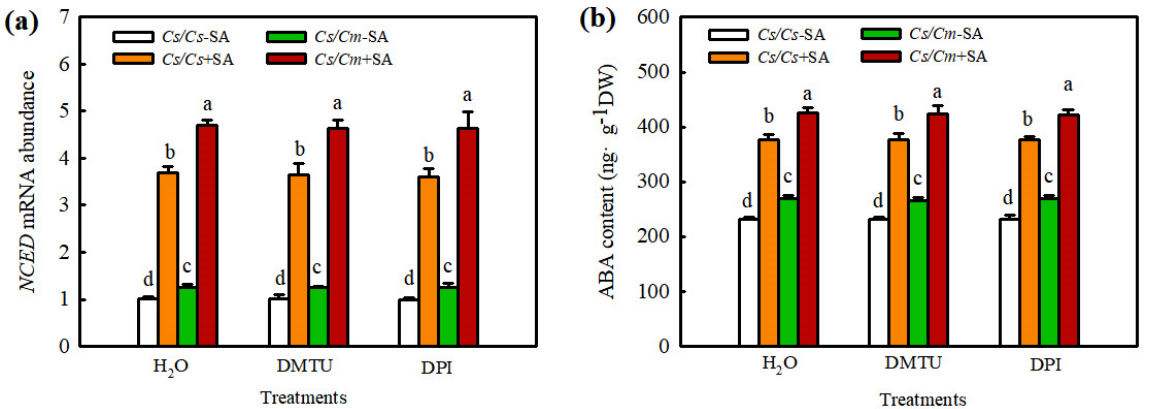
Figure 9. Effect of DMTU and DPI on SA − induced NCED mRNA abundance ( a ) and ABA content ( b ) in grafted cucumber plants. The plants were treated with 5.0 mM DMTU, 0.1mM DPI, or deionized water (H 2 O), and 8 h later, 1.0 mM SA was sprayed. At 12 h after pretreatment, the plants were exposed to 5 °C for 12 h. Data are presented as the means ± SD ( n = 3). Different letters indicate a statistical significance between samples at p < 0.05.